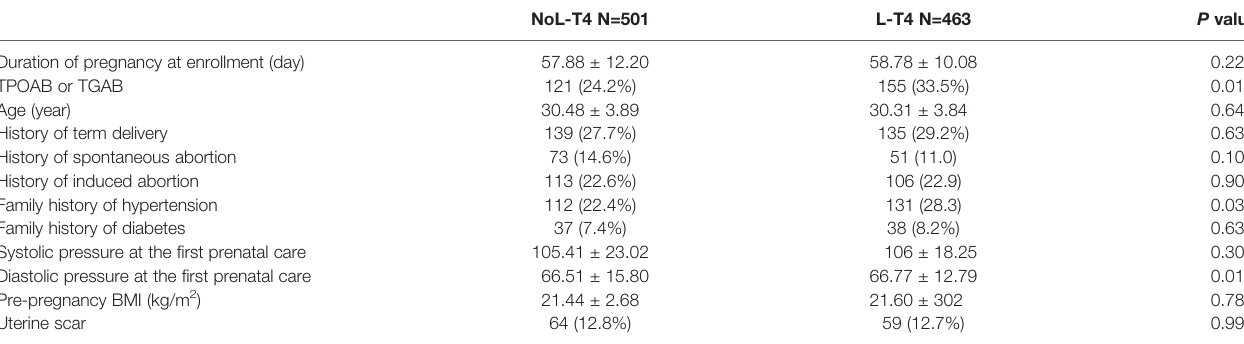
501subjectsdidnottreatwithL-T4and463subjectstreatedwithL-T4arepresented inthistable.Forcontinuousvariables,mean±standarddeviation(SD)arepresented;forcategorical variables, absolute numbers and percentage of the total are presented. Systolic and diastolic blood pressure at fi rst prenatal care. TPOAB, thyroid peroxidase antibody; TGAB, thyroglobulin antibody.